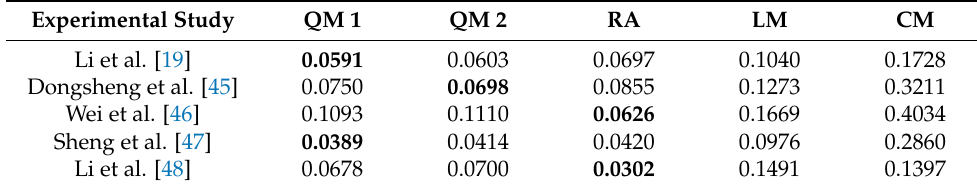
Table 4. WLS values obtained for the existing models against all reported experiments of bamboo